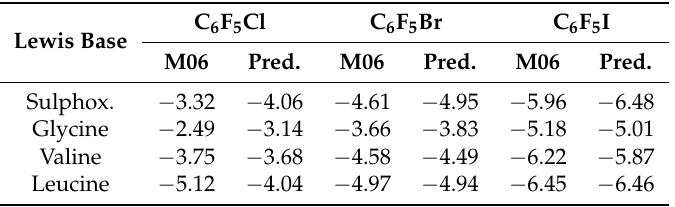
Table 3. The energies for each pair of new halogen-bond acceptor and donor at the M06-2X/aVTZ level, along with the energies predicted by the model, in kcal/mol. Lewis Base